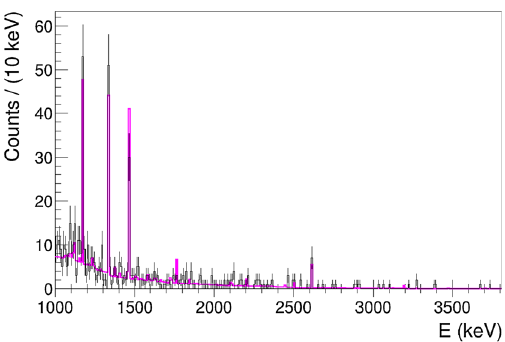
Fig. 1 Measured X-rays spectrum (black histogram) and simulated background distribution (magenta histogram) in the energy range Δ